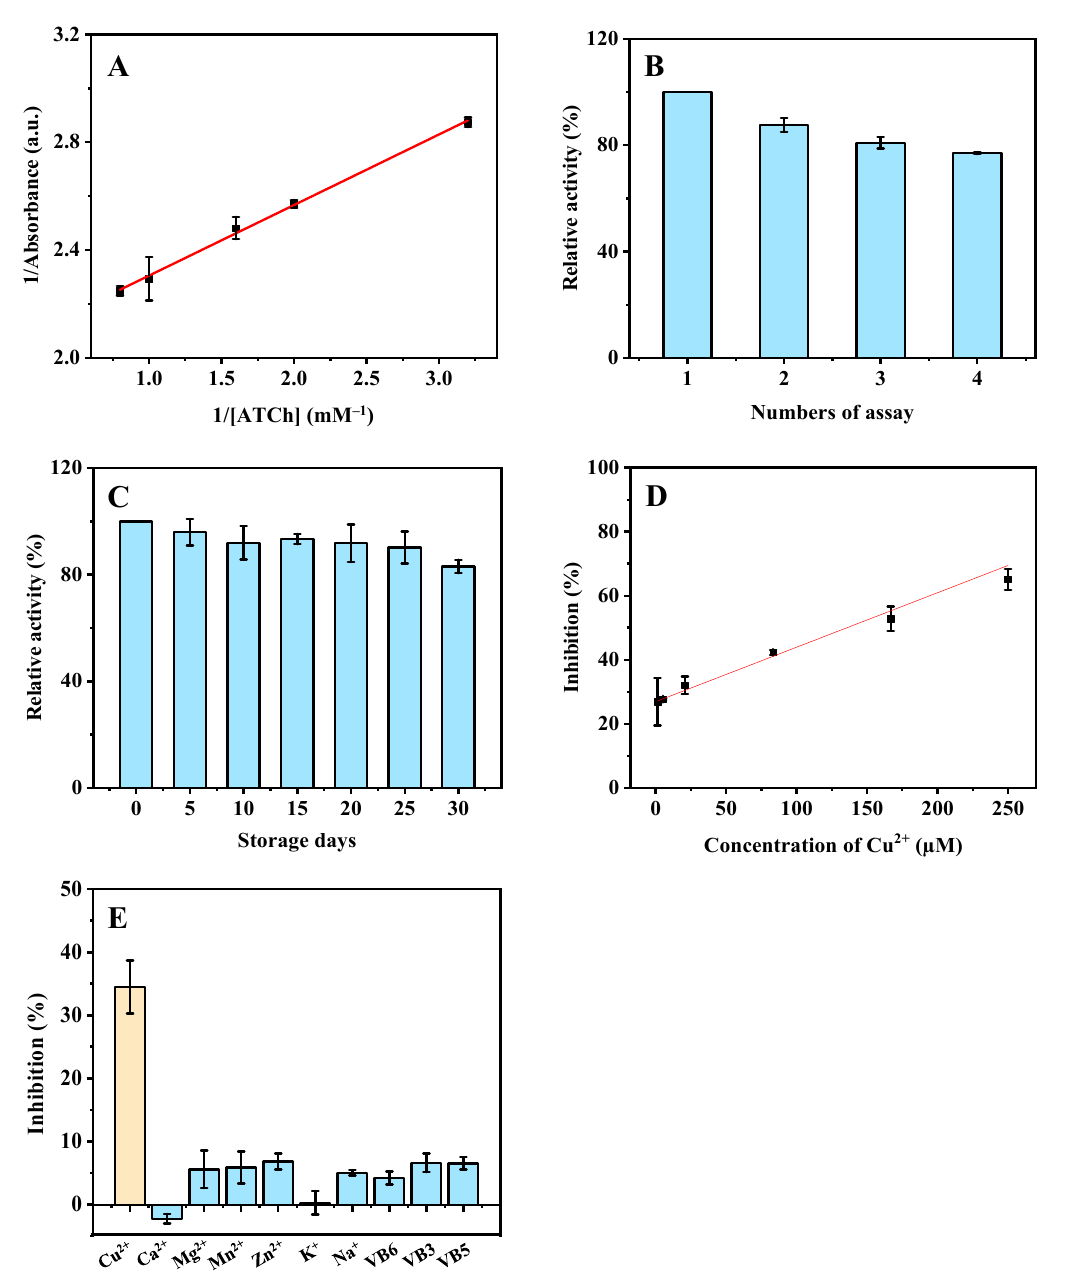
Figure 5. Double reciprocal plot ( A ), the reusability ( B ), storage stability ( C ), linearity ( D ), and the selectivity ( E ) for the detection of Cu 2+ based on the AChE-like activity of ZIF-8 under the optimized conditions. ZIF-8, 4 mg; buffer pH, 7.5; reaction time, 15 min; centrifugation time, 1 min for ( A – E ); ATCh concentrations are from 0.3 to 1.3 mM for ( A ). Cu 2+ concentrations are from 1.3 to 250.0 µ M for ( D ); the concentrations of Cu 2+ and other substances are 20.8 µ M and 83.3 µ M for ( E ), respectively. In addition, to investigate the intrinsic ALP-like catalytic activity of ZIF-8, the K m was measured via the absorbance of the product (TNB) at various substrate (AAP) concentra- tions (0.9, 1.5, 1.8, 2.7, and 3.6 mM). The obtained linear regression equation of the Lin- eweaver–Burk plot is y = 8.8691 x – 0.7946 (R 2 = 0.9916), where x is the reciprocal of AAP concentration and y is the reaction velocity (the absorbance of TNB) (Figure 6A). The de- termined value of K m is 11.2 mM, which is similar to that of natural ALP (substrate: diso- dium phenyl phosphate, 3.8 mM) [14].